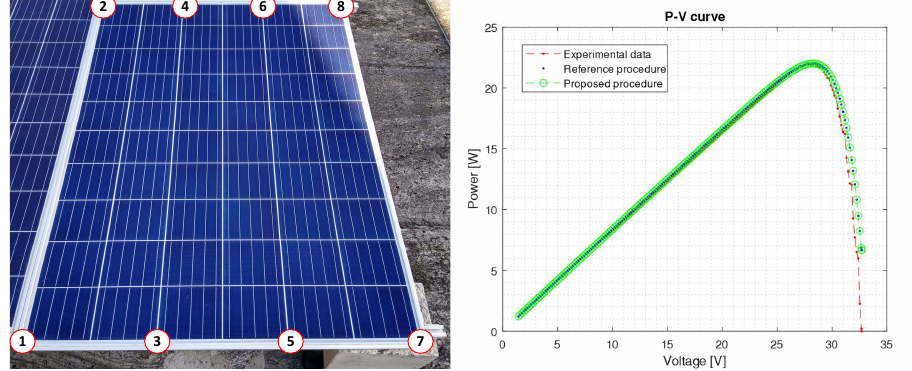
Figure 18. Left : photo of the PV panel for Experiment 1 (17 October 2019 3:14 p.m. G = 586.5 [W/m 2 ], and T a = 28.3°). Right : P-V curves obtained experimentally and with proposed and reference methods. The numbers correspond to the PMs.